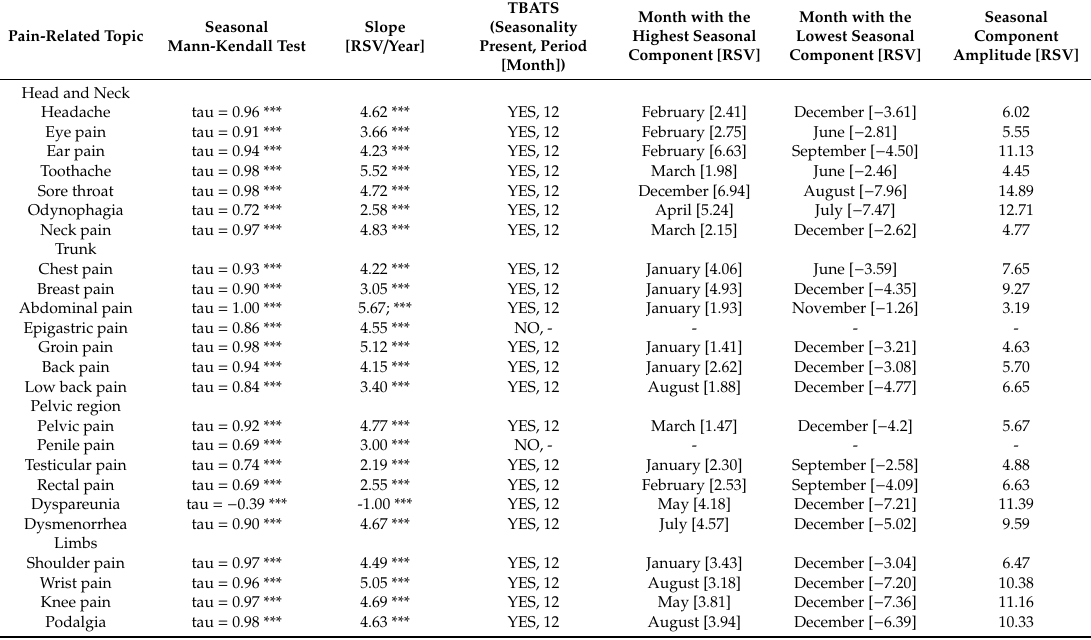
Figure 3. Time trends for relative search volumes of non-adjusted pain-related topics. Table 3. Time series analysis of non-adjusted pain-related